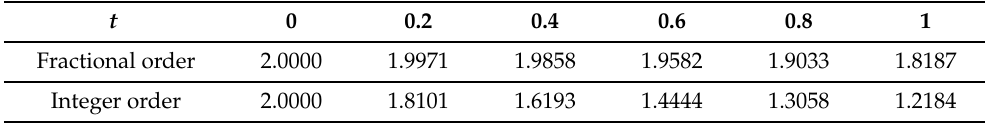
Table 1. Comparison of numerical solutions of u ( t ) in Example